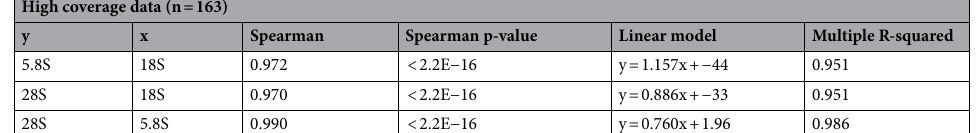
High coverage data (n =